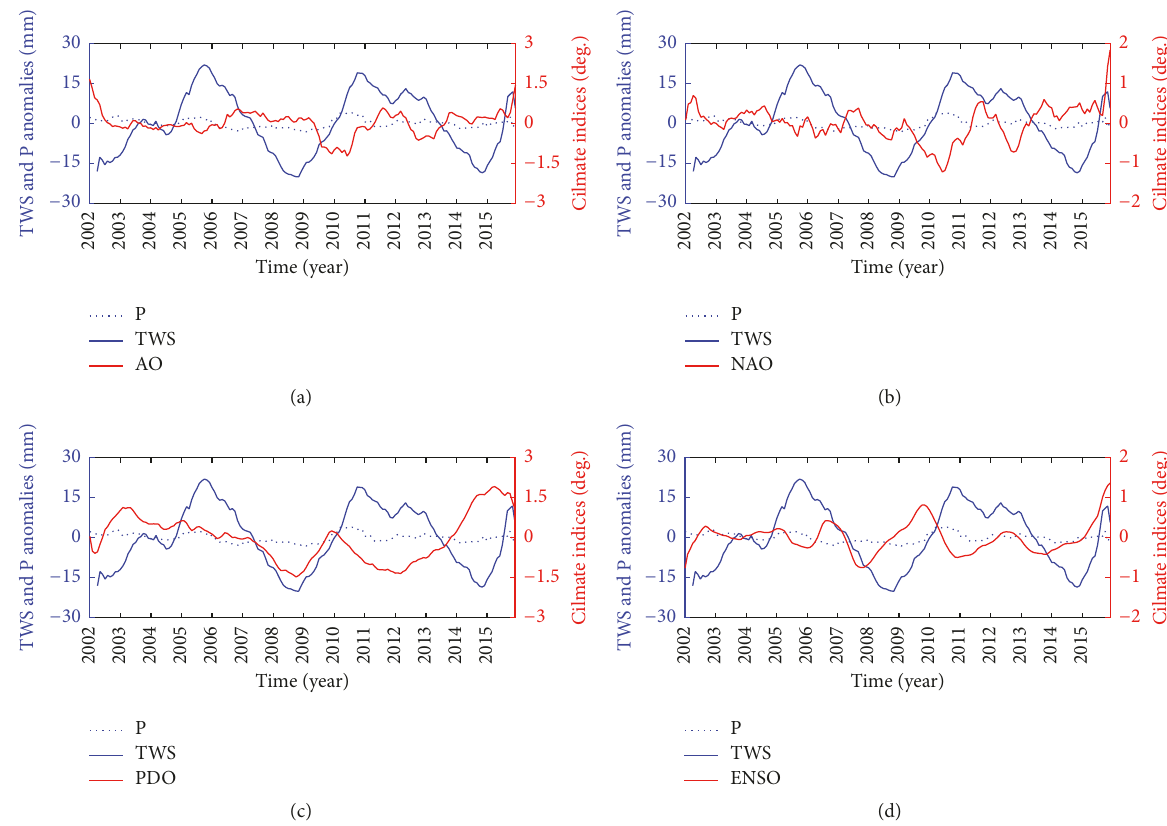
Figure 6: The thirteen-month moving smoothed time series of nonseasonal variations in precipitation, TWSA, and climate indices of (a) AO, (b) NAO, (c) PDO, and (d) ENSO/NINO3.4.